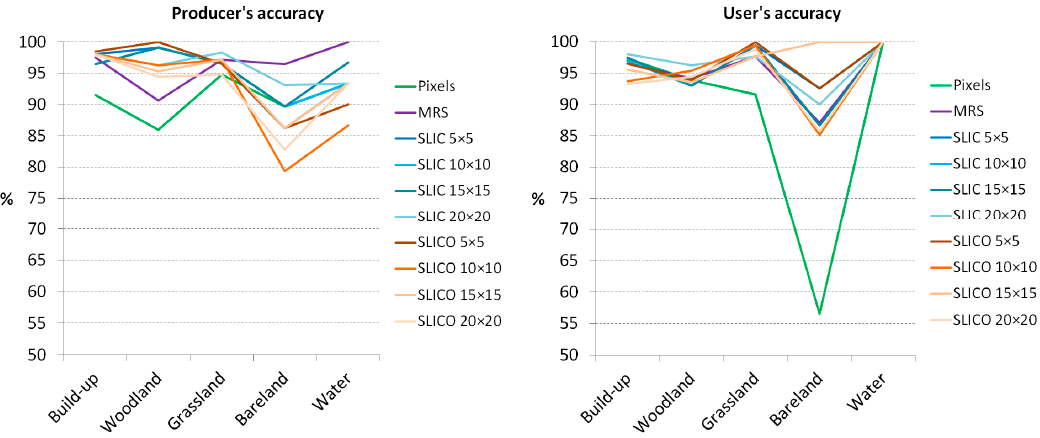
Figure 8. Producer’s and user’s accuracy for T2 RF classification results.